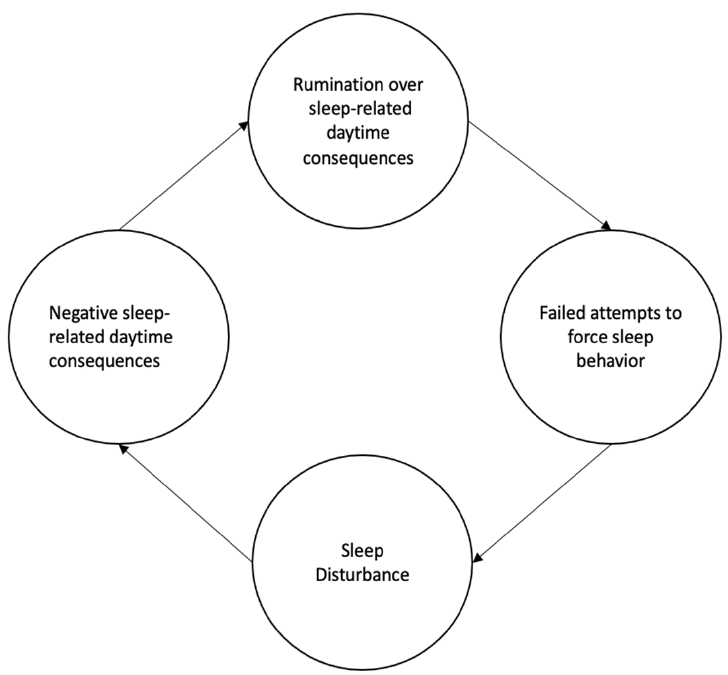
Figure 1. Conceptual model of the chronic cycle of rumination, unsuccessful sleep behavior attempts, sleep disturbance, and daytime consequences.